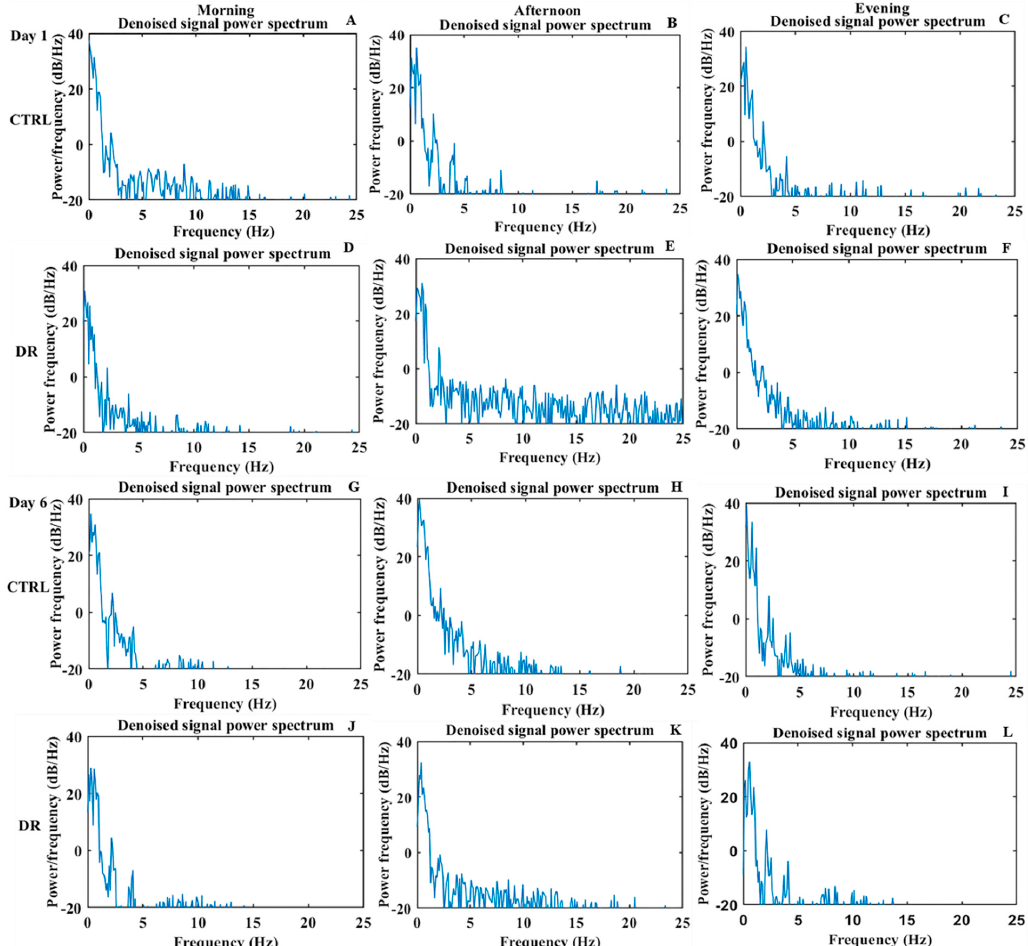
Figure 5. The power spectrum of denoised signals on Day 1 and Day 6. Graphs ( A – C ) correspond to the results of the control treatment measured in the morning, afternoon, and evening on Day 1; ( D – F ) correspond to the results of the drought treatment measured in the morning, afternoon, and evening on Day 1; ( G – I ) correspond to the results of the control treatment measured in the morning, afternoon, and evening on Day 6; and ( J – L ) correspond to the results of the drought treatment measured in the morning, afternoon, and evening on Day 6.